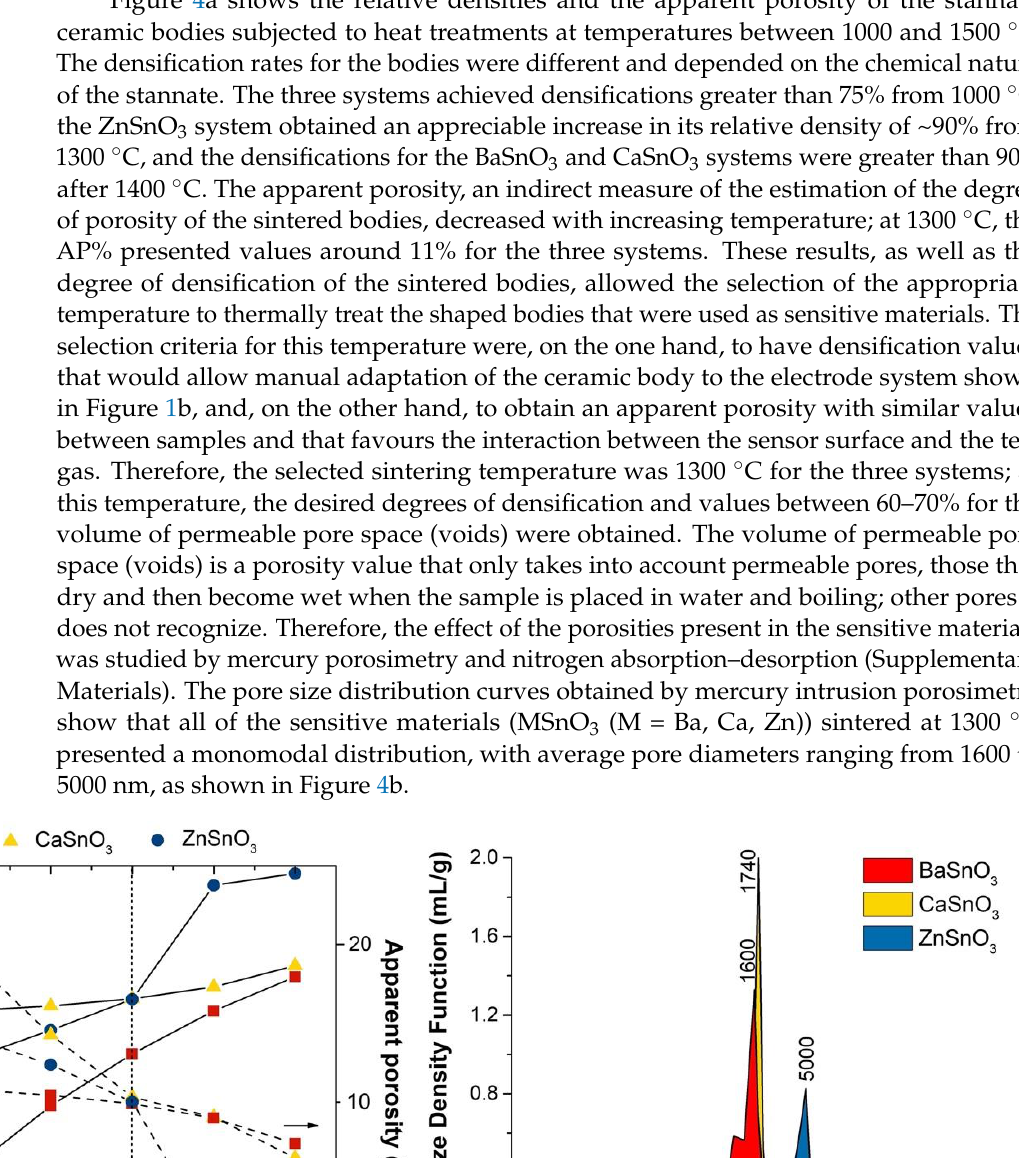
Figure 5. XRD patterns of sintered ceramic bodies based on MSnO 3 perovskites (M = Ba, Ca, Zn). The Raman spectra of the ceramic bodies of the MSnO 3 system (M = Ba, Ca, Zn) meas- ured at room temperature are shown in Figure 6. For the BaSnO 3 sample, bands at 258, 413, 455, 549, 650, and 831 cm −1 are observed, similar to those identified in the study by James et al. [60]. According to the XRD pattern presented above, only the crystalline phase of BaSnO 3 is observed, with an ideal cubic structure belonging to the space group Pm3m (O h ). However, this should not show the first-order Raman active mode (this was